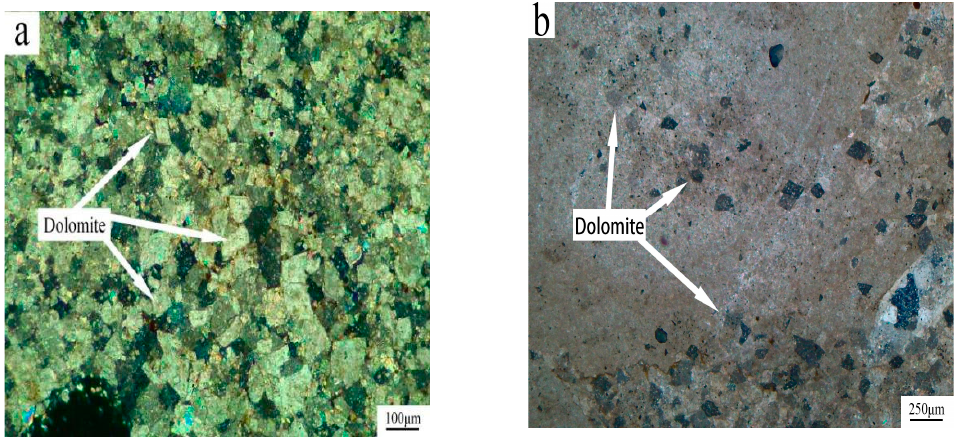
Figure 2. The distribution of dolomite crystals inside SFP and ZC rocks: ( a ) SFP mosaic distribution, ( b ) ZC dispersive distribution.